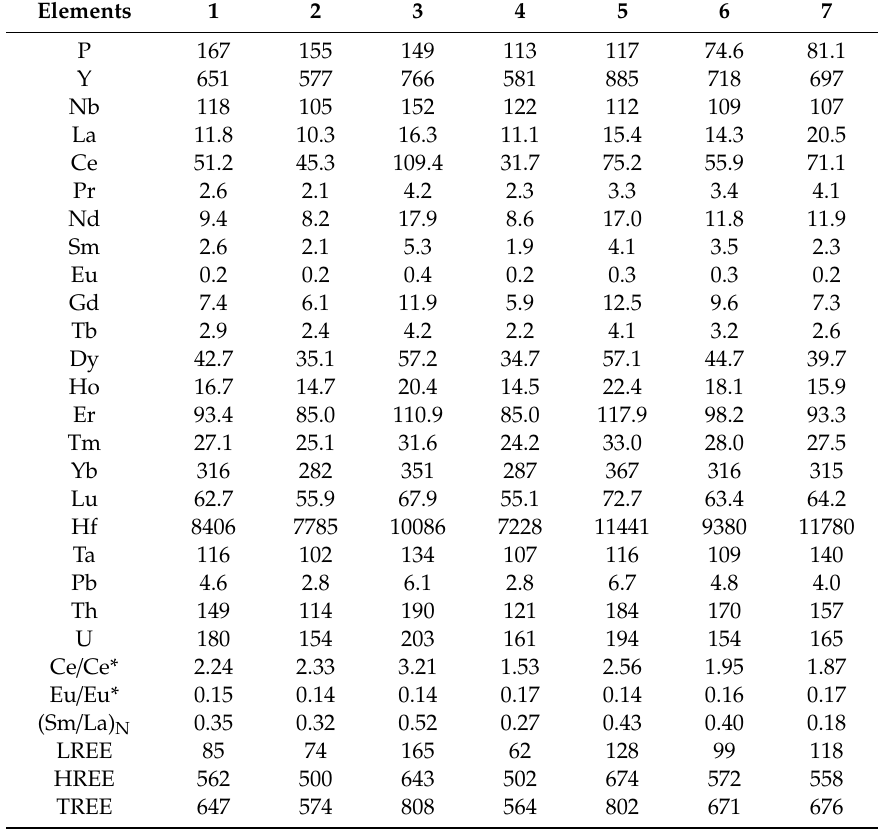
Table 3. Laser ablation ICP-MS analyses (in parts per million) of zircon from the quartz–allanite